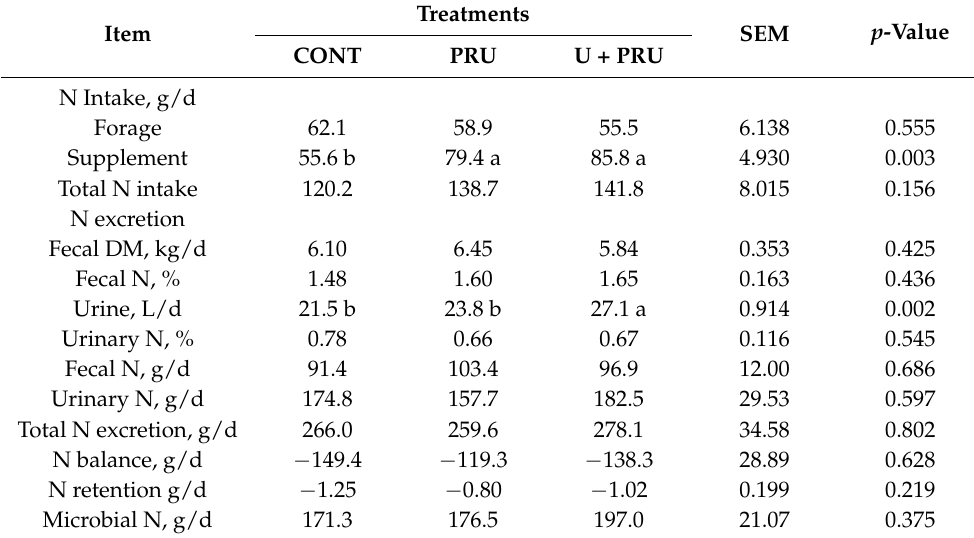
Table 5. Characterization of nitrogen utilization in Nellore steers supplemented with post-ruminal urea and conventional urea during the dry season.